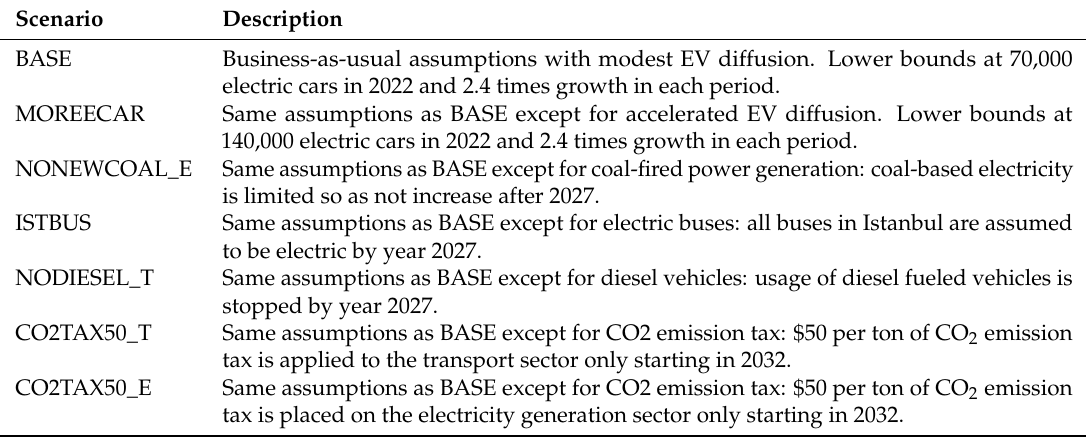
Table 5. Scenario Summary.